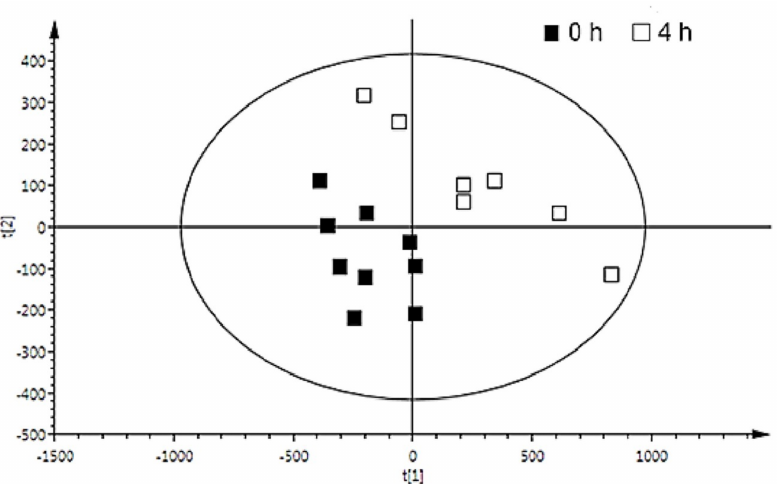
Figure 1. Partial least square discriminant analysis (PLS-DA) of Ultra-Performance Liquid Chromatography coupled to Quadrupole Time of Flight Mass Spectrometry (UPLC-QTOF-MS) urine data of time point 0 ( (cid:4) ) and time point 4 h post consumption of peas ( (cid:3) ). Q 2 , 0.4; R 2 X, 0.41; t [1], PLS component 1; t [2], PLS component 2. At the timepoint 4 h, urine samples were unavailable for two